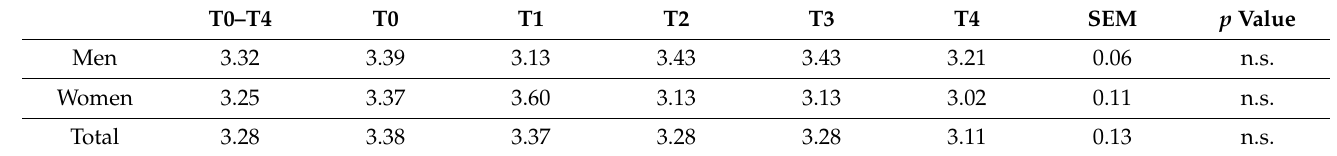
Table 6. Effect of tannin supplementation on sensory evaluation of